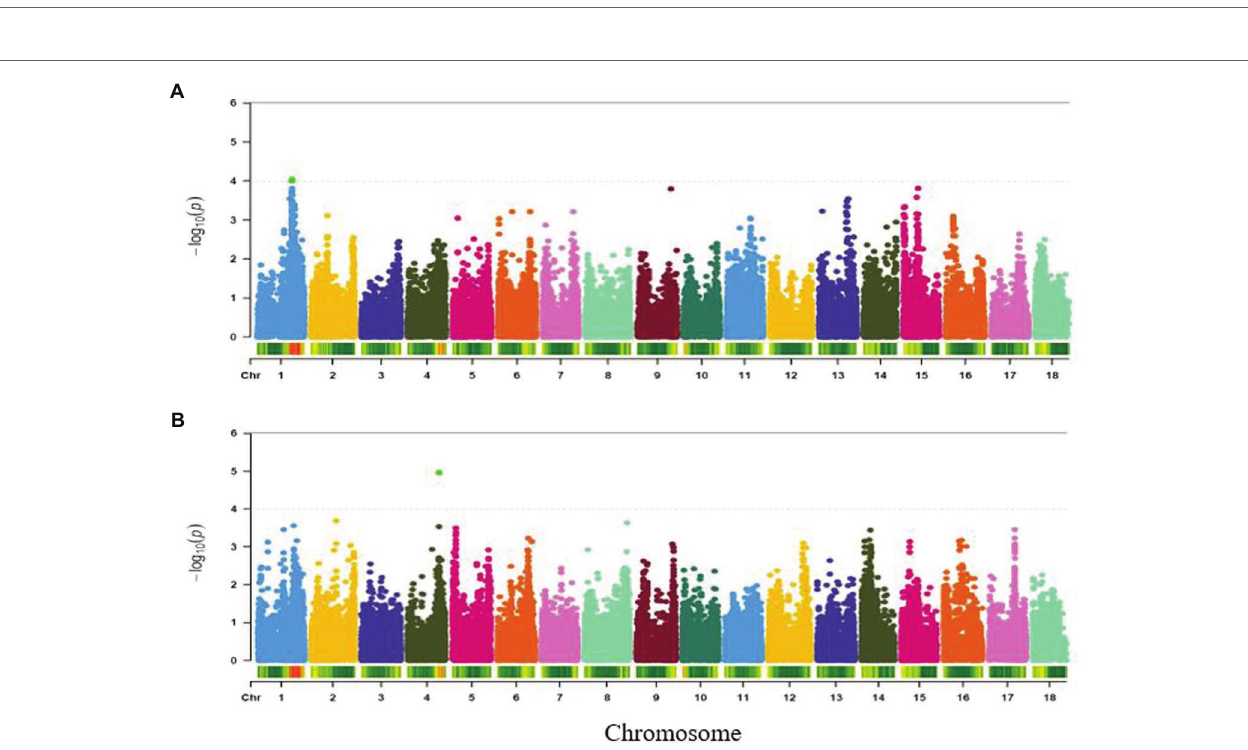
FIGURE 7 | Manhattan plots for GWAS based on best linear unbiased predictions for (A) colour, and (B) firmness. The dashed horizontal line depicts the genome- wide significance